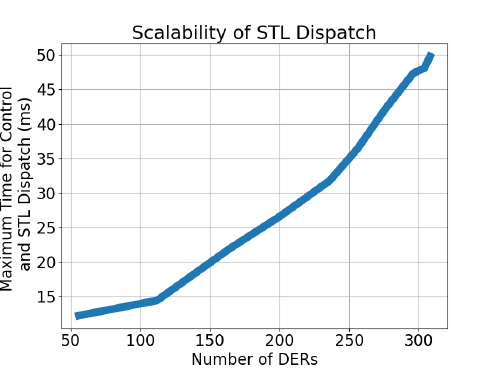
Figure 9. Scalability of real-time control and service transformer layer (STL) coordination of distributed energy resources